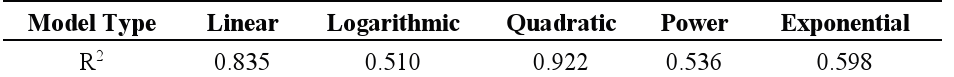
Table 3. The fitting degree for different regression model between the sensitive factor u(B4) and SSC